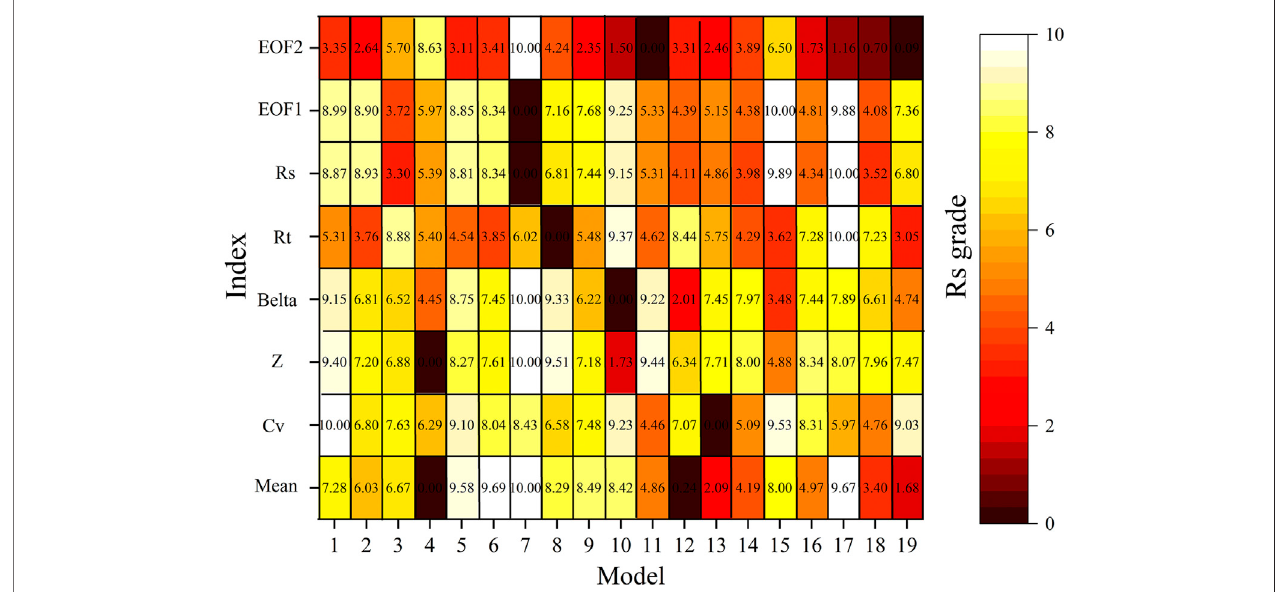
FIGURE 3 | Comparison of the RS scores of the eight indicators over the 19 GCMs, 1 – 19 are the 19 CMIP6 models listed in Table 1 : ACCESS-CM2, ACCESS- ESM1-5, BCC-CSM2-MR, CMCC-CM2-SR5, CNRM-CM6-1, CNRM-ESM2-1, FGOALS-f3-L, FGOALS-g3, GFDL-CM4, GFDL-ESM4, IITM-ESM, INM-CM4-8,